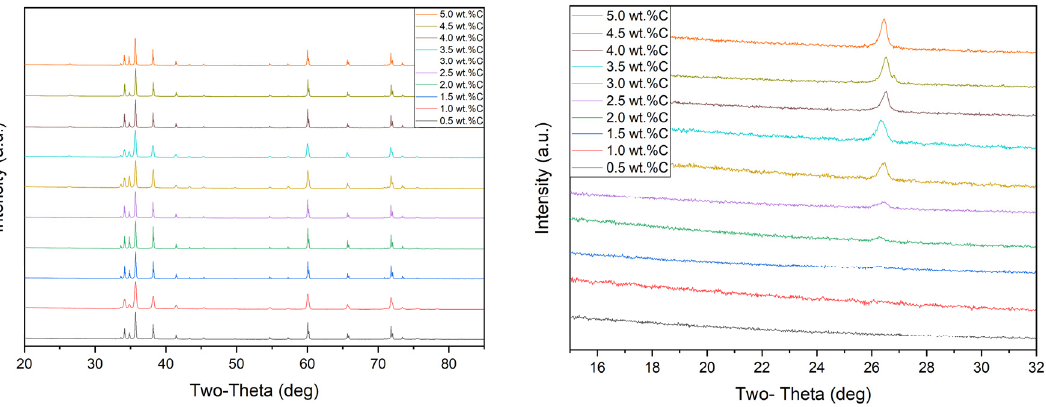
Figure 3. The phase identification of the XRD patterns of dry mixed SiC with different amounts of carbon addition ( left ), an enlarged view (2 θ = 15°–32°) of X-ray diffraction patterns of dry mixed SiC ( right ).